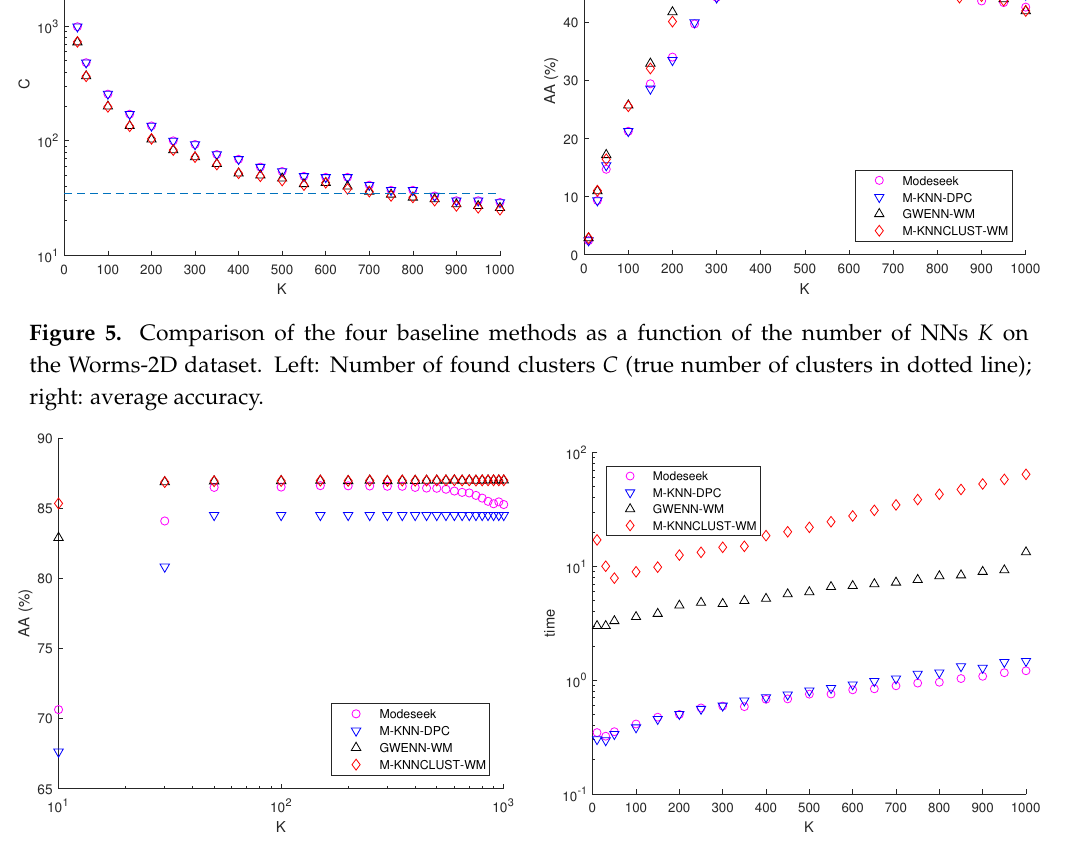
Figure 6. Comparison of the four baseline methods as a function of the number of NNs K on the Worms-64D dataset. Left: average accuracy; right: computational time